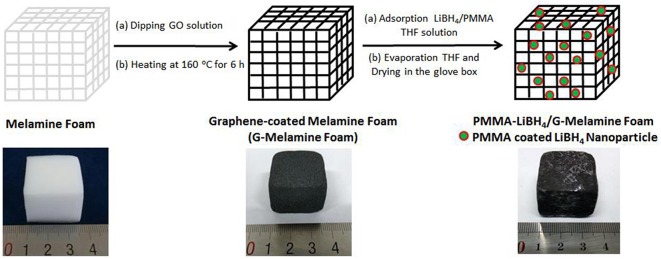
Illustration of preparation of PMMA-LiBH4/GMF.